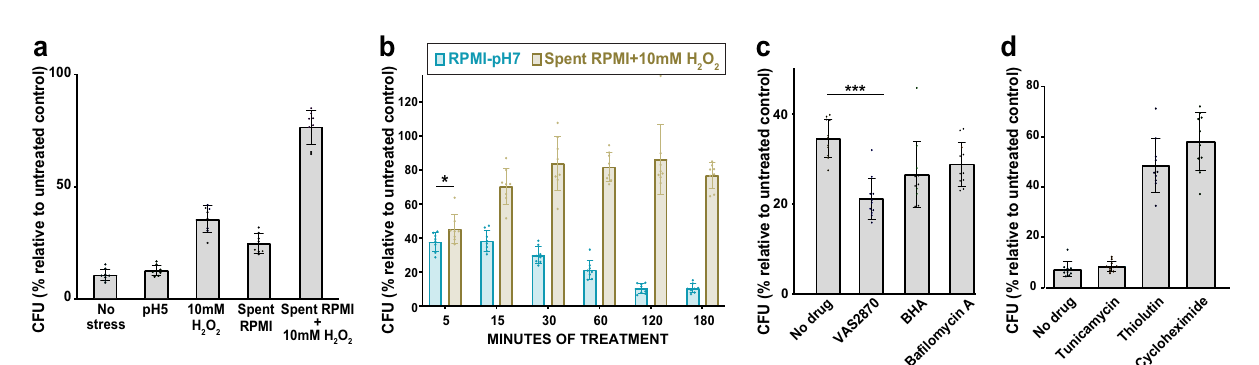
Fig. 2 | Internalization of C. glabrata cells by macrophages enhances their tolerancetocidalantifungaldrugs.a C.glabrata cellseitherincubatedinRPMIor macrophagesfor3hand theirsurvivalwereassessedbefore and after1hexposure to micafungin (0.06 µ g/ml). b C. glabrata released from macrophages at different times post-infection showed signi fi cantly higher survival upon treatment with 0.125 µ g/mlmicafunginfor1hcomparedtosimilarlytreatedplanktoniccells. n =10 biological replicates over two independent experiments (* p <0.03, ** p <0.003, *** p <0.0003,two-sidedpairedt-test). c C.glabrata releasedfrommacrophages3h post-infection and treated for 1h with either caspofungin (0.125 µ g/ml) or amphotericin B (2 µ g/ml) showed higher survival than similarly treated planktonic cells. n =10 biological replicates over two independent experiments.